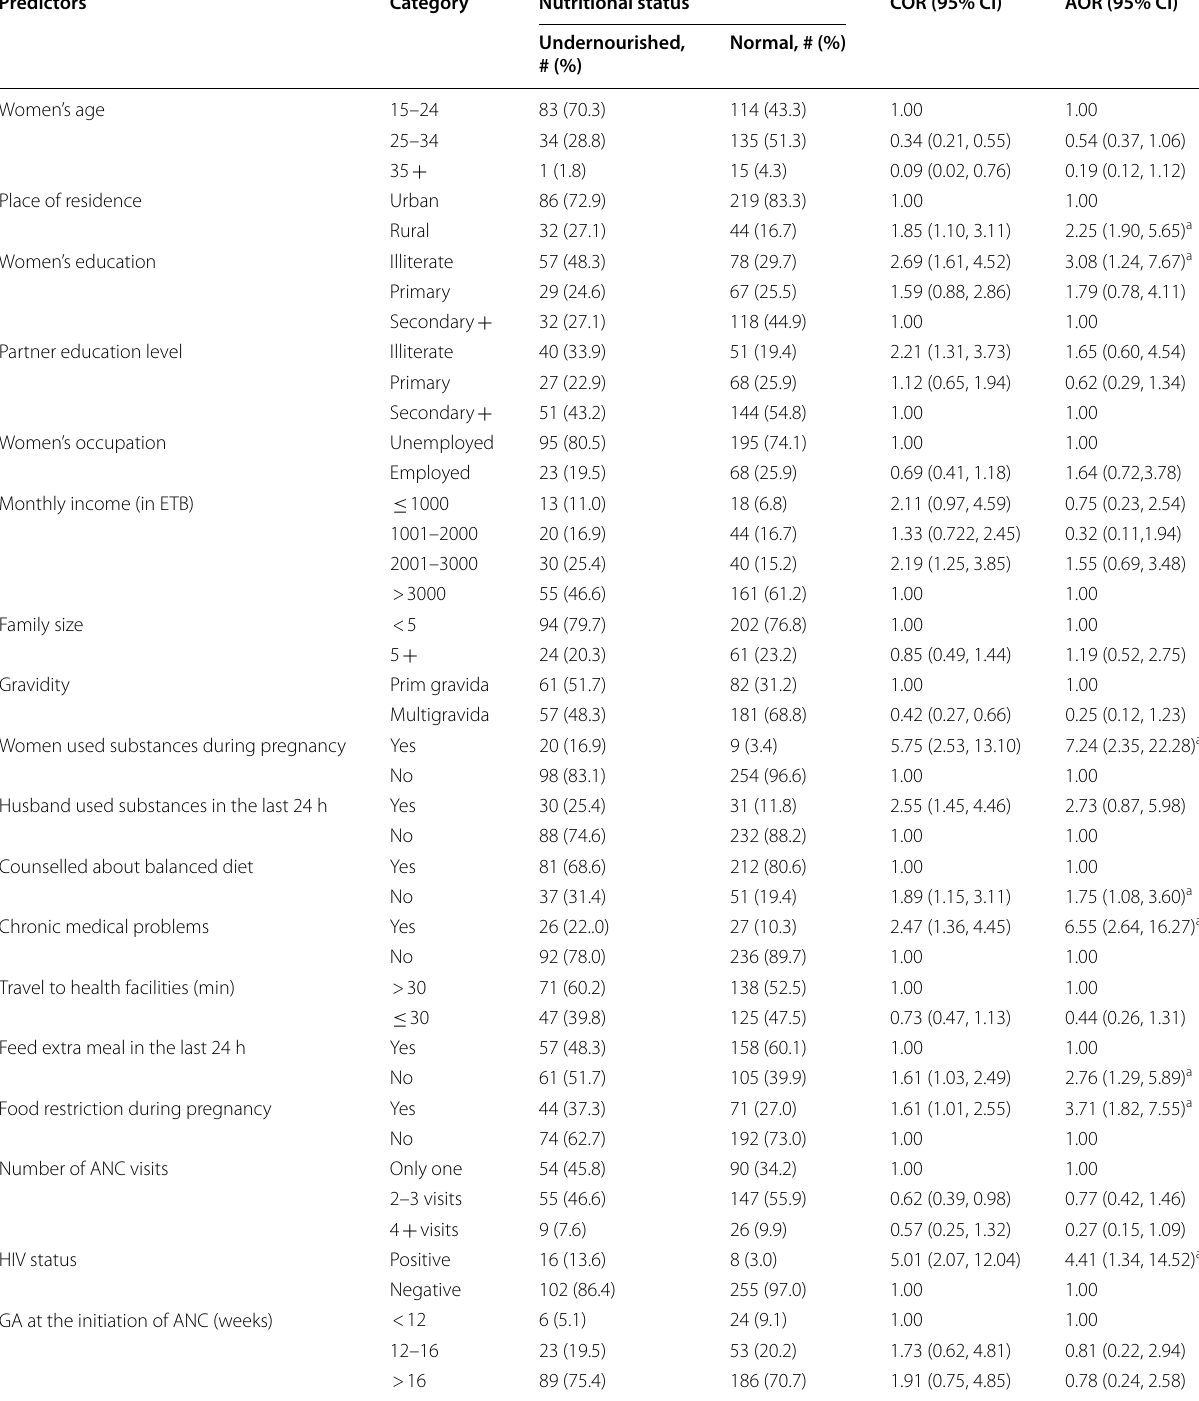
Table 4 Factors associated with undernutrition among pregnant women in the Afar region, northeast